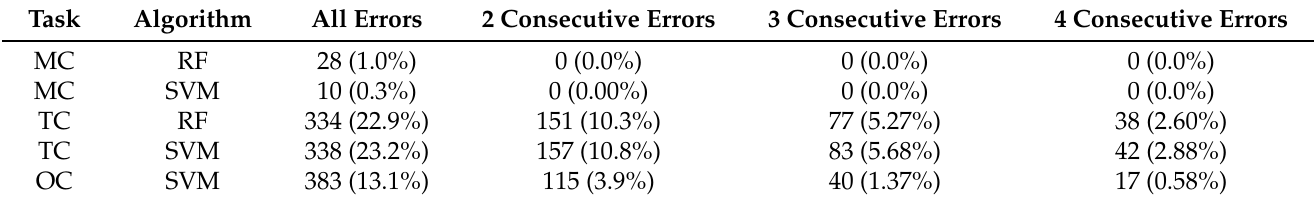
Table 11. Number of consecutive errors (both false negatives and false positives) by model and prediction task. All errors are also shown for comparison. Task